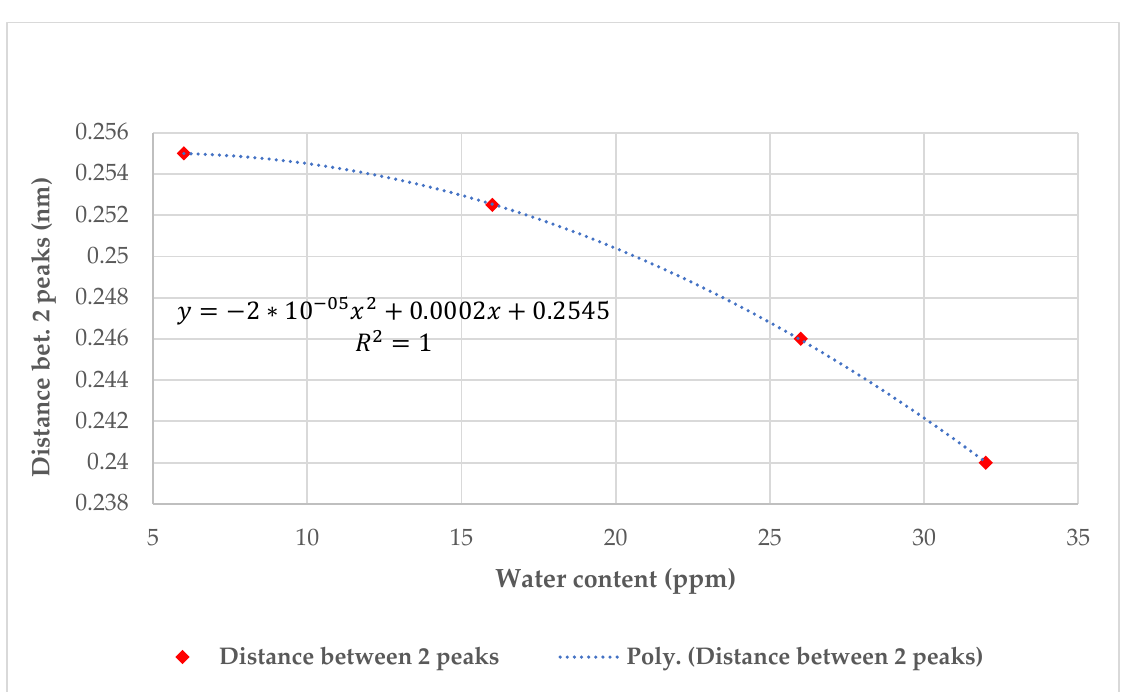
Figure 15. Wavelength domain feedback curves for different exposure times to MO water content after insertion of FOS.